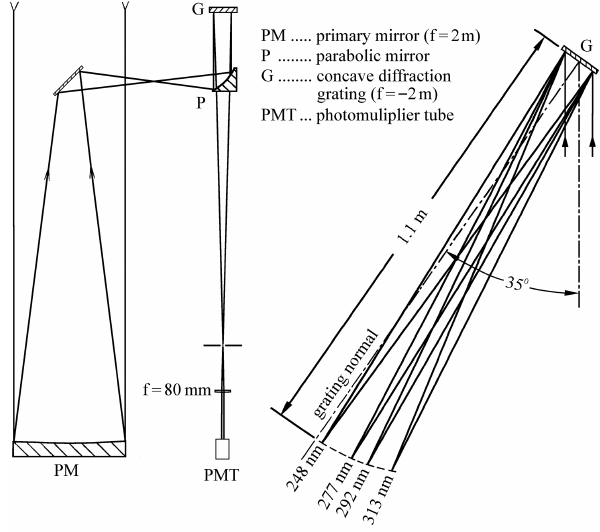
Figure 7. Layout of the two grating spectrographs; α = 35 ◦ is the Wadsworth angle chosen, corresponding to a wavelength of 240.0nm. The choice of angle was limited by the space available in the housing of the spectrograph, also considering the big PMTs initially